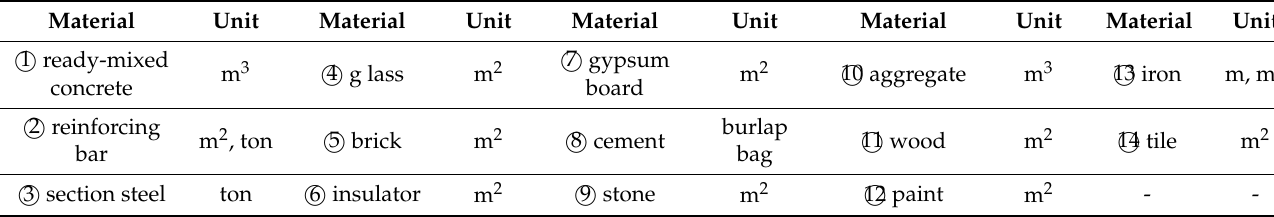
Table 1. Representative units of building